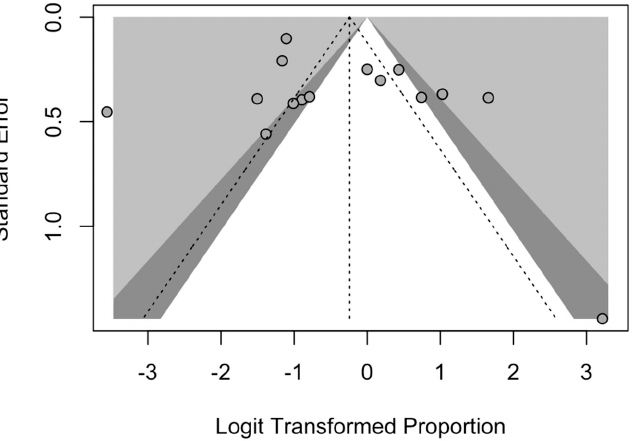
Figure 7. Border-enhanced funnel plots for estimates included in the meta-analysis. Visual inspec- tion of contour-enhanced funnel plots suggested the substantial evidence of publication bias, but this was substantially rejected by Egger test (i.e., t = − 1.50, df = 14, intercept = 2.5879, SE = 1.7307, p - value =